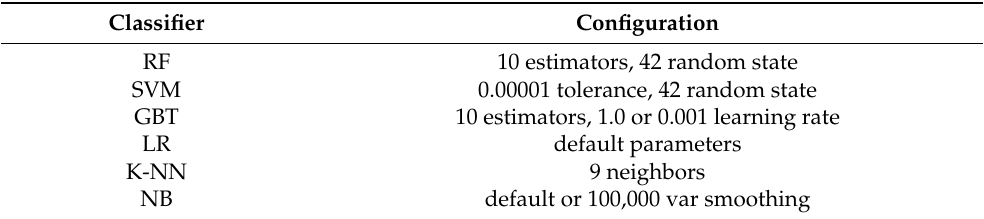
Table 1. Classifier